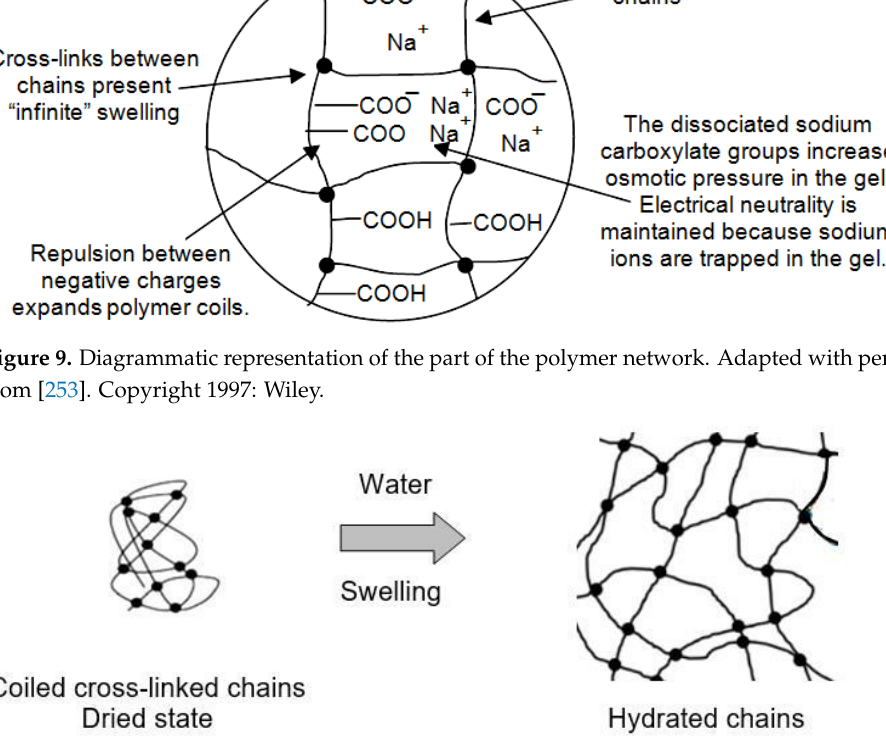
Figure 10. Changes in a three-dimensional network of polymer chains during swelling.